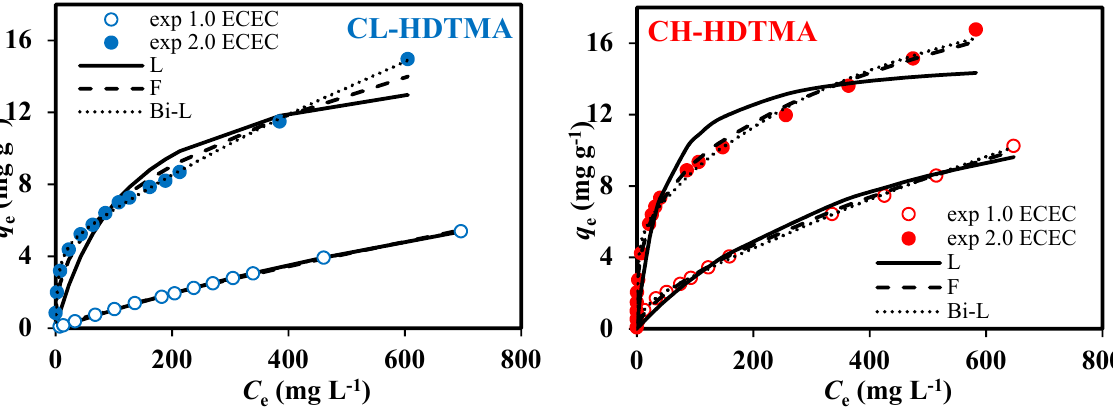
Figure 7. Comparison of equilibrium isotherms and modeling curves obtained for Cr(VI) sorption on SMZs.